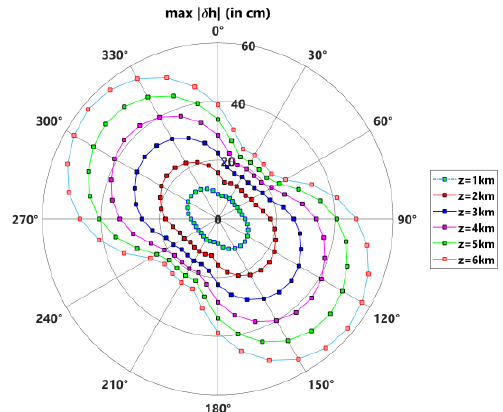
Figure 7. Impact of azimuth-angle variations on horizontal ( h  ) coordinates using SWEN17 model at different flight altitudes in Sweden (the polar plots show maximum absolute value of h  ). Unit: cm